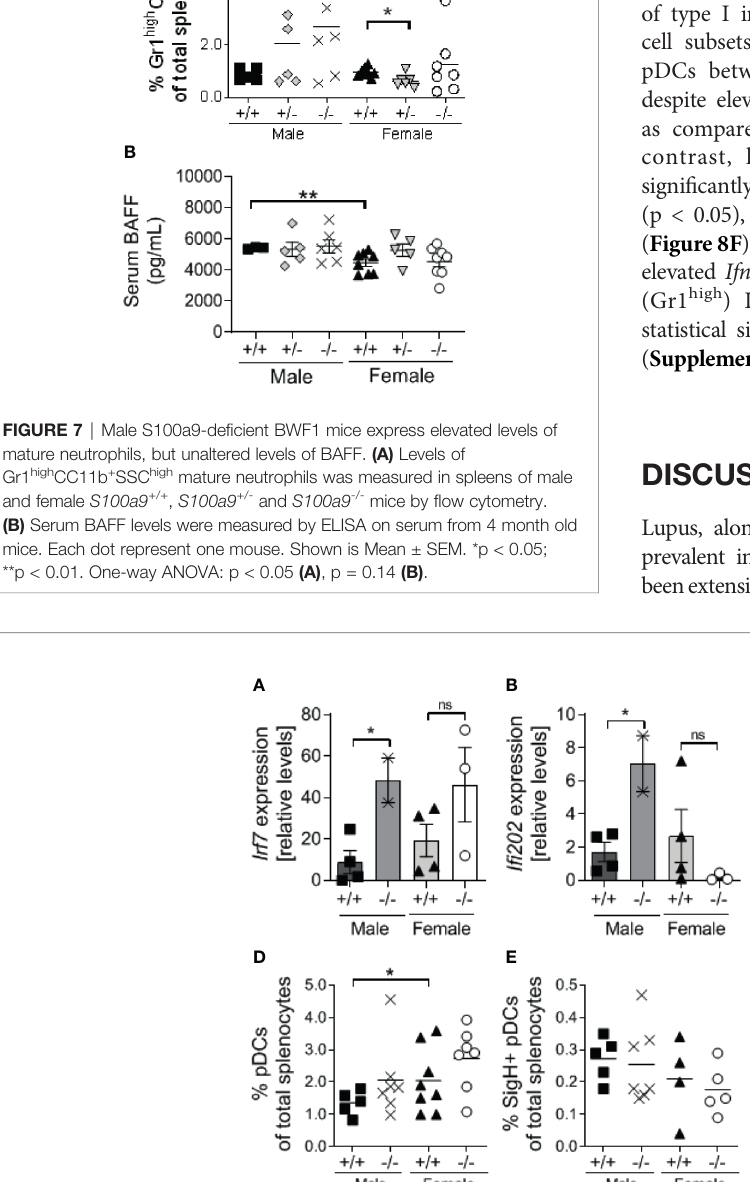
FIGURE 8 | Male S100a9-de fi cient BWF1 mice express elevated expression of interferon-stimulated genes and increased levels of low-density granulocytes. (A – C) Real-time RT-PCR was performed on total splenocytes obtained from a subset of S100a9 +/+ and S100a9 -/- male and female BWF1 mice at the time of harvest ( ≥ 7 months of age) and levels of I fi 202 (A) , Irf7 (B) , and Isg15 (C) were determined. Levels of total pDCs (D) , SigH + pDCs (E) , and Low-density granulocytes (LDGs) (F) , were determined by fl ow cytometry. Each dot represent one mouse. Shown is Mean ± SEM. *p < 0.05; **p < 0.01, ns, not statistically signi fi cant. One-way ANOVA: p < 0.05 (A) , p = 0.08 (B) , p = 0.07 (C) , p = 0.09 (D) , p = 0.67 (E) , p = 0.0001 (F)